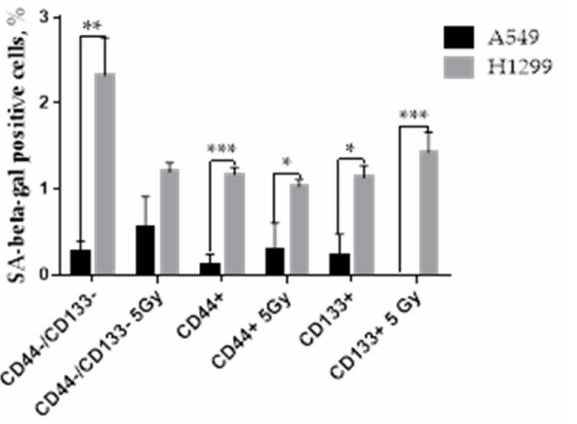
Figure 9. The proportion of senescence-associated beta-galactosidase (SA-beta-gal)-positive cells in CD-sorted populations of A549 and H1299 cell lines 24 h after 5 Gy irradiation. Data are means ± SEM of more than three independent experiments. Where: * p < 0.05, ** p < 0.01, *** p <